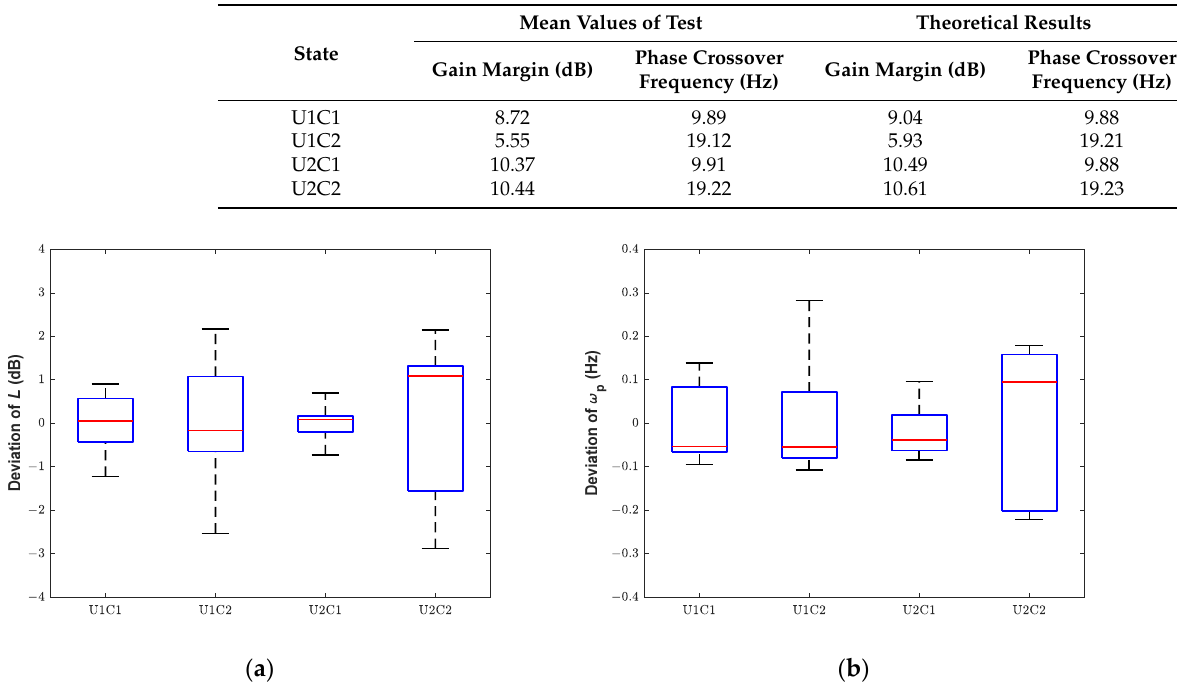
Figure 25. Deviations of gain margin and phase crossover frequency from their mean values for different states at Ma = 1.5. ( a ) Gain margin. ( b ) Phase crossover frequency.